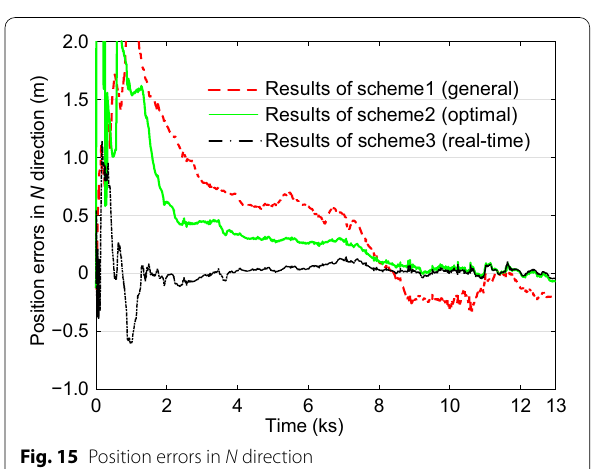
Fig. 15 Position errors in N direction